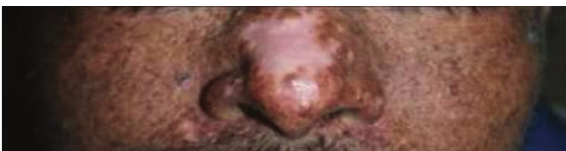
Figure 3: Atrophic, hypopigmented skin of the nose.